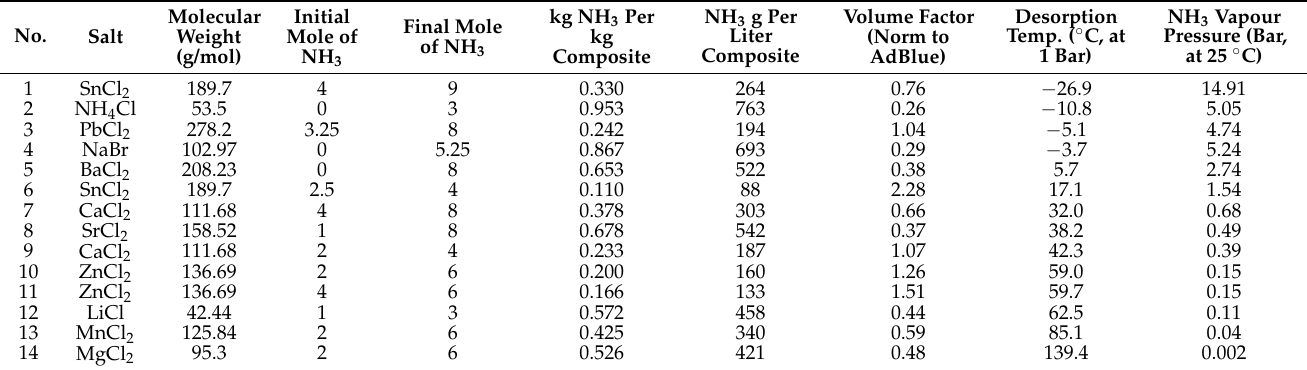
Table 1. The properties of different reactant salts for the composite sorbents